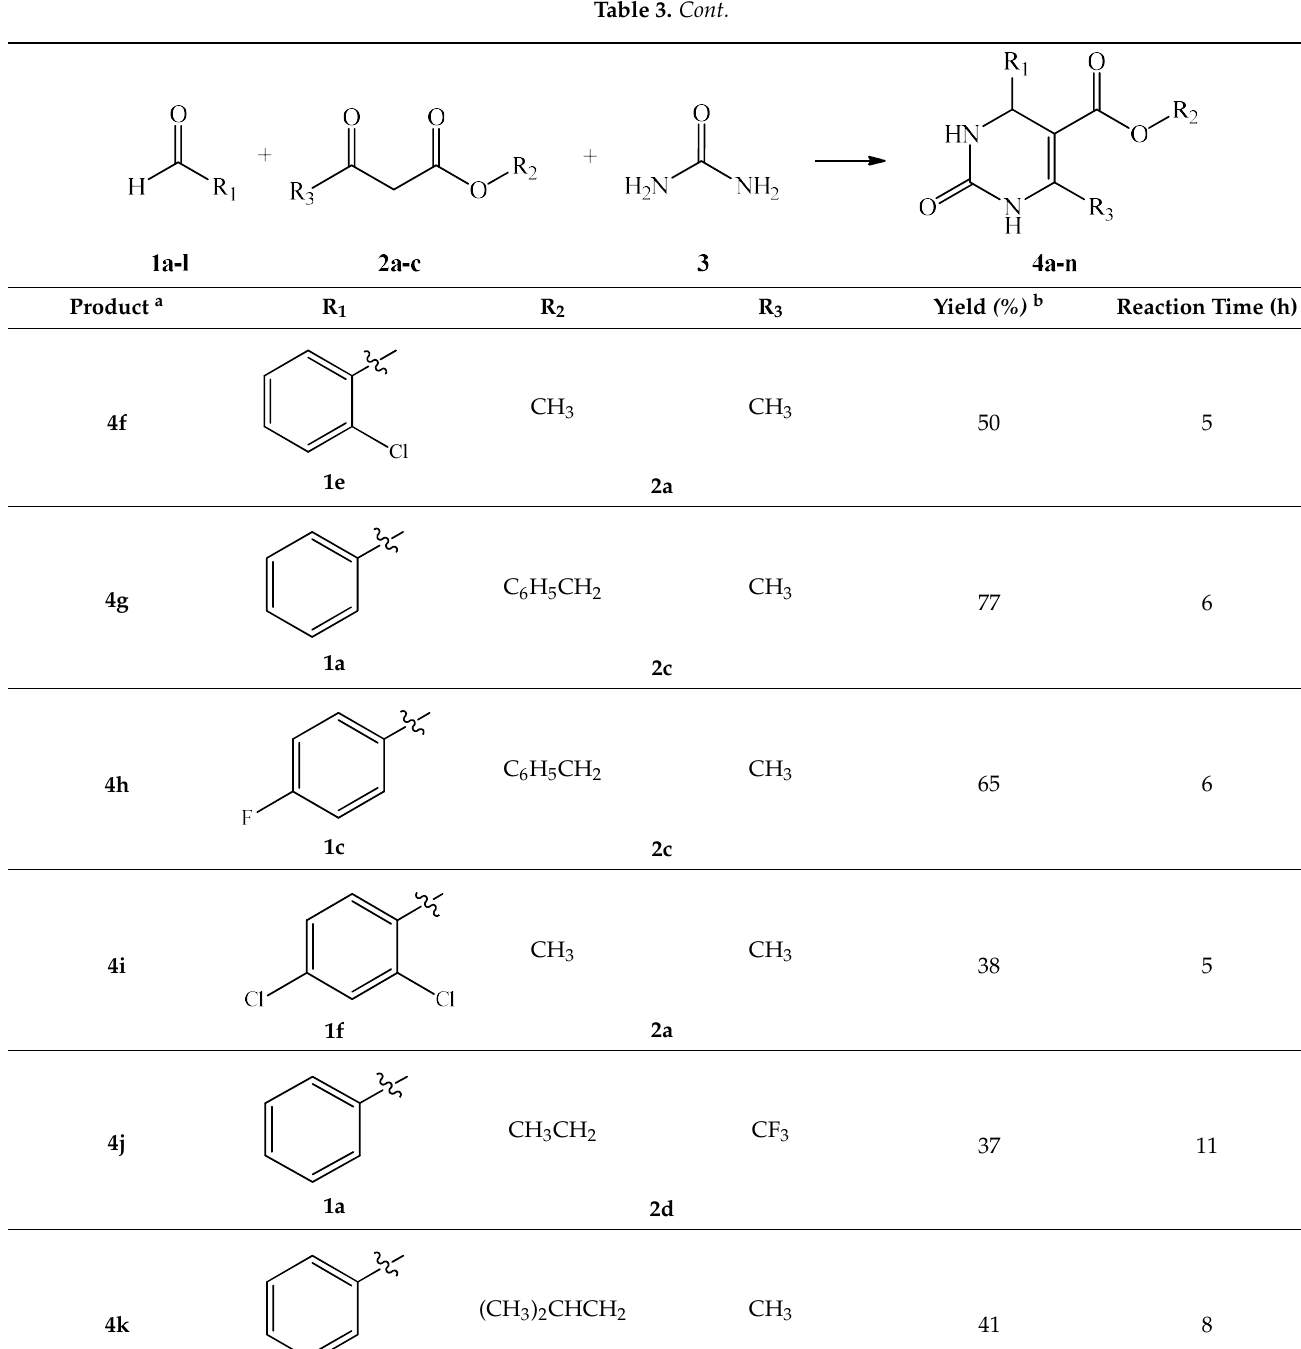
Table 3. Yields and reaction times for the Biginelli reaction involving aldehydes ( 1a - l ), β-ketoesters ( 2a-c ) and urea ( 3